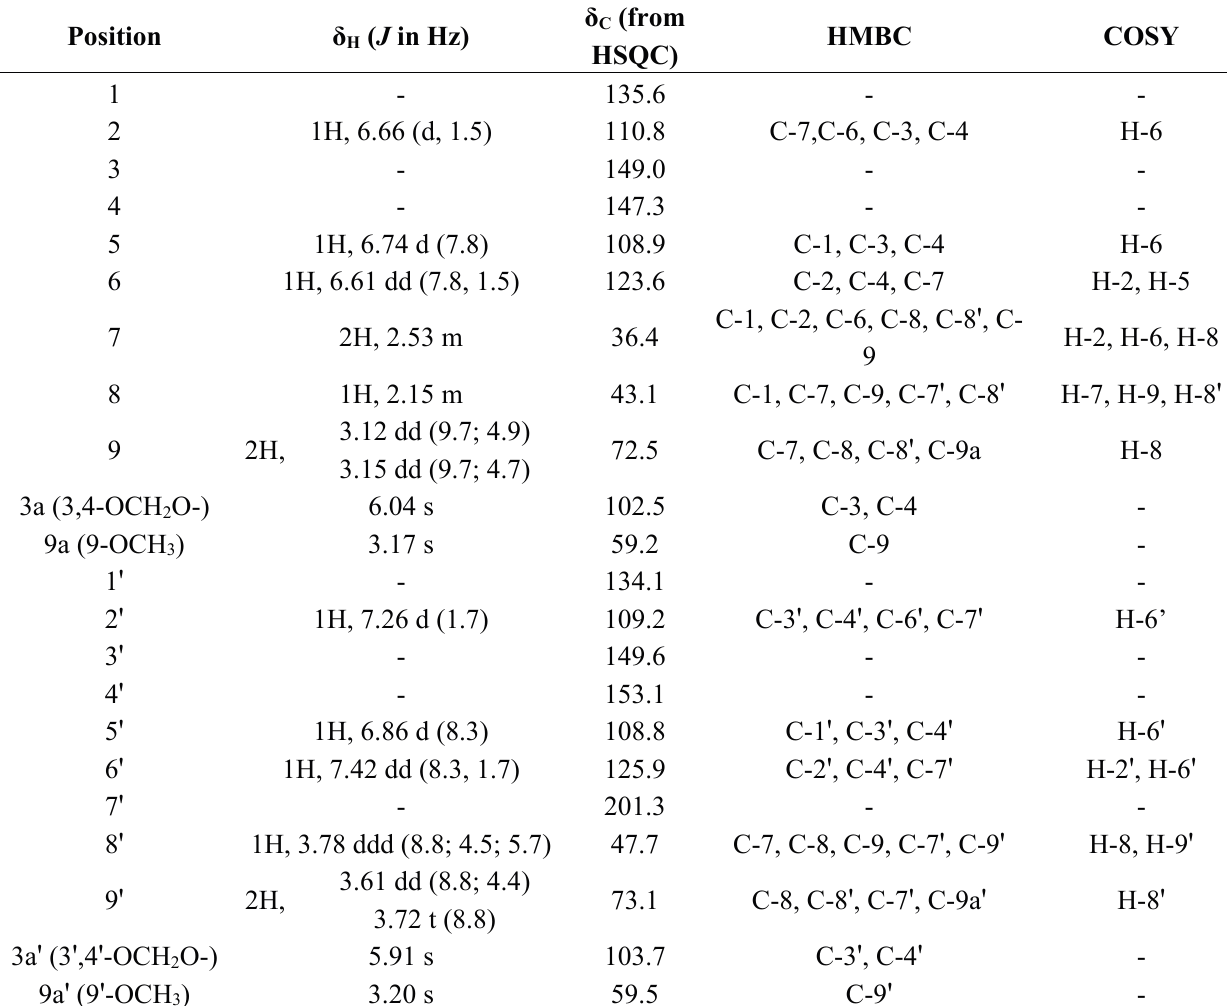
Figure 1. Selected COSY (Correlation Spectroscopy) and HMBC correlations of 1 . Table 1. 1D- and 2D-NMR experiments data of 1